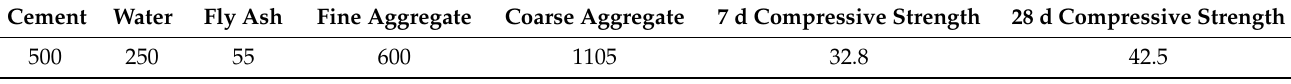
Table 1. Cement concrete mix ratio (kg/m − 3